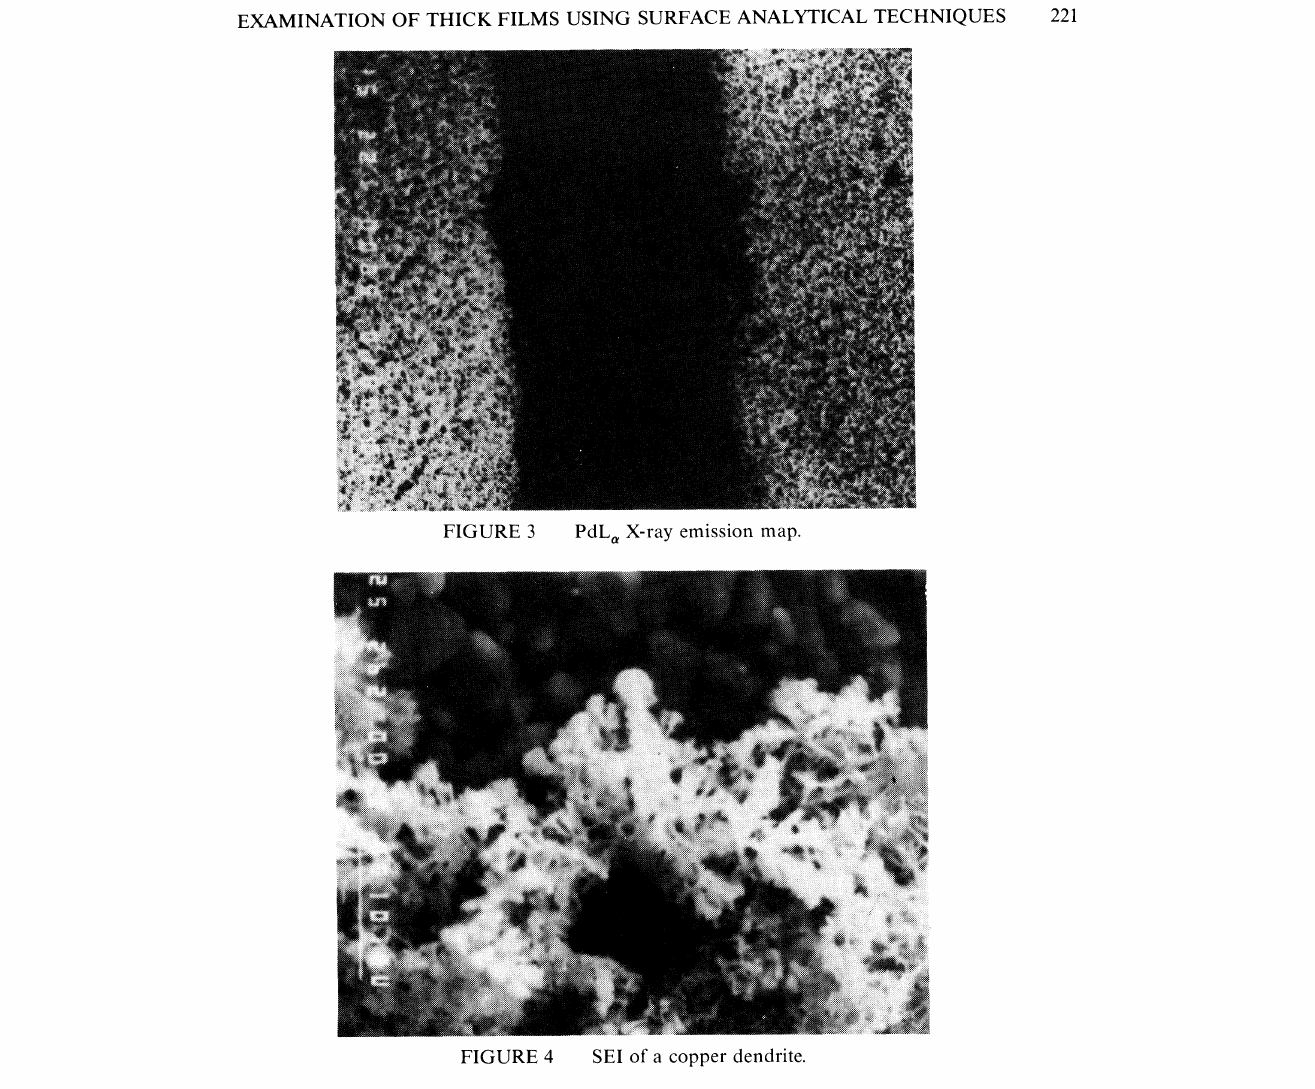
FIGURE 4 SEI of a copper